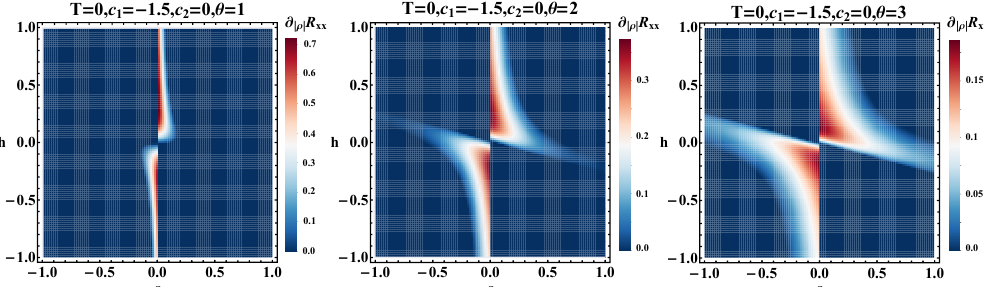
Figure 9 . Mott-insulating region for θ = 1 , 2 , 3 in the parameter plane for Maxwell-Chern-Simons electrodynamics at zero temperature. We set c 1 = − 1 . 5 and c 2 = 0